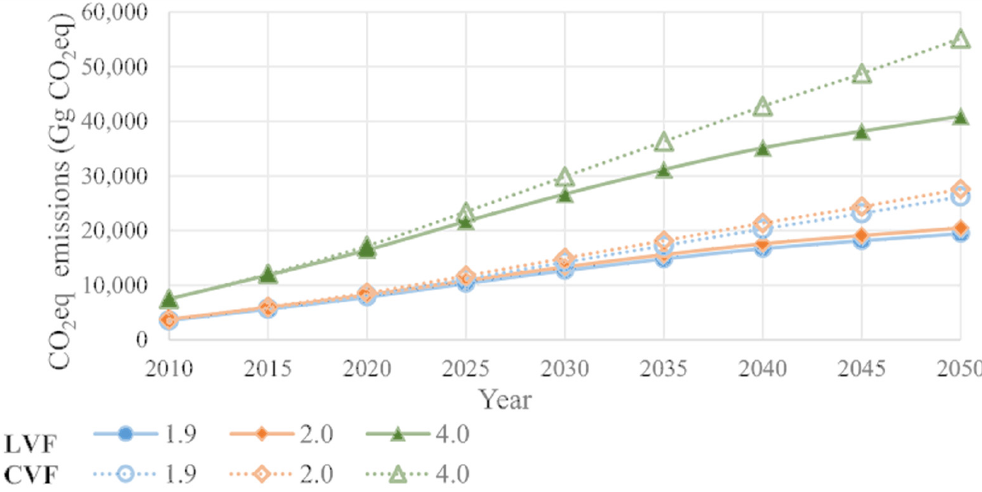
Figure 22. CO 2 eq emissions generated by clean central power plants for three electricity demand per capita and two population models. Prepared by the authors based on own results.